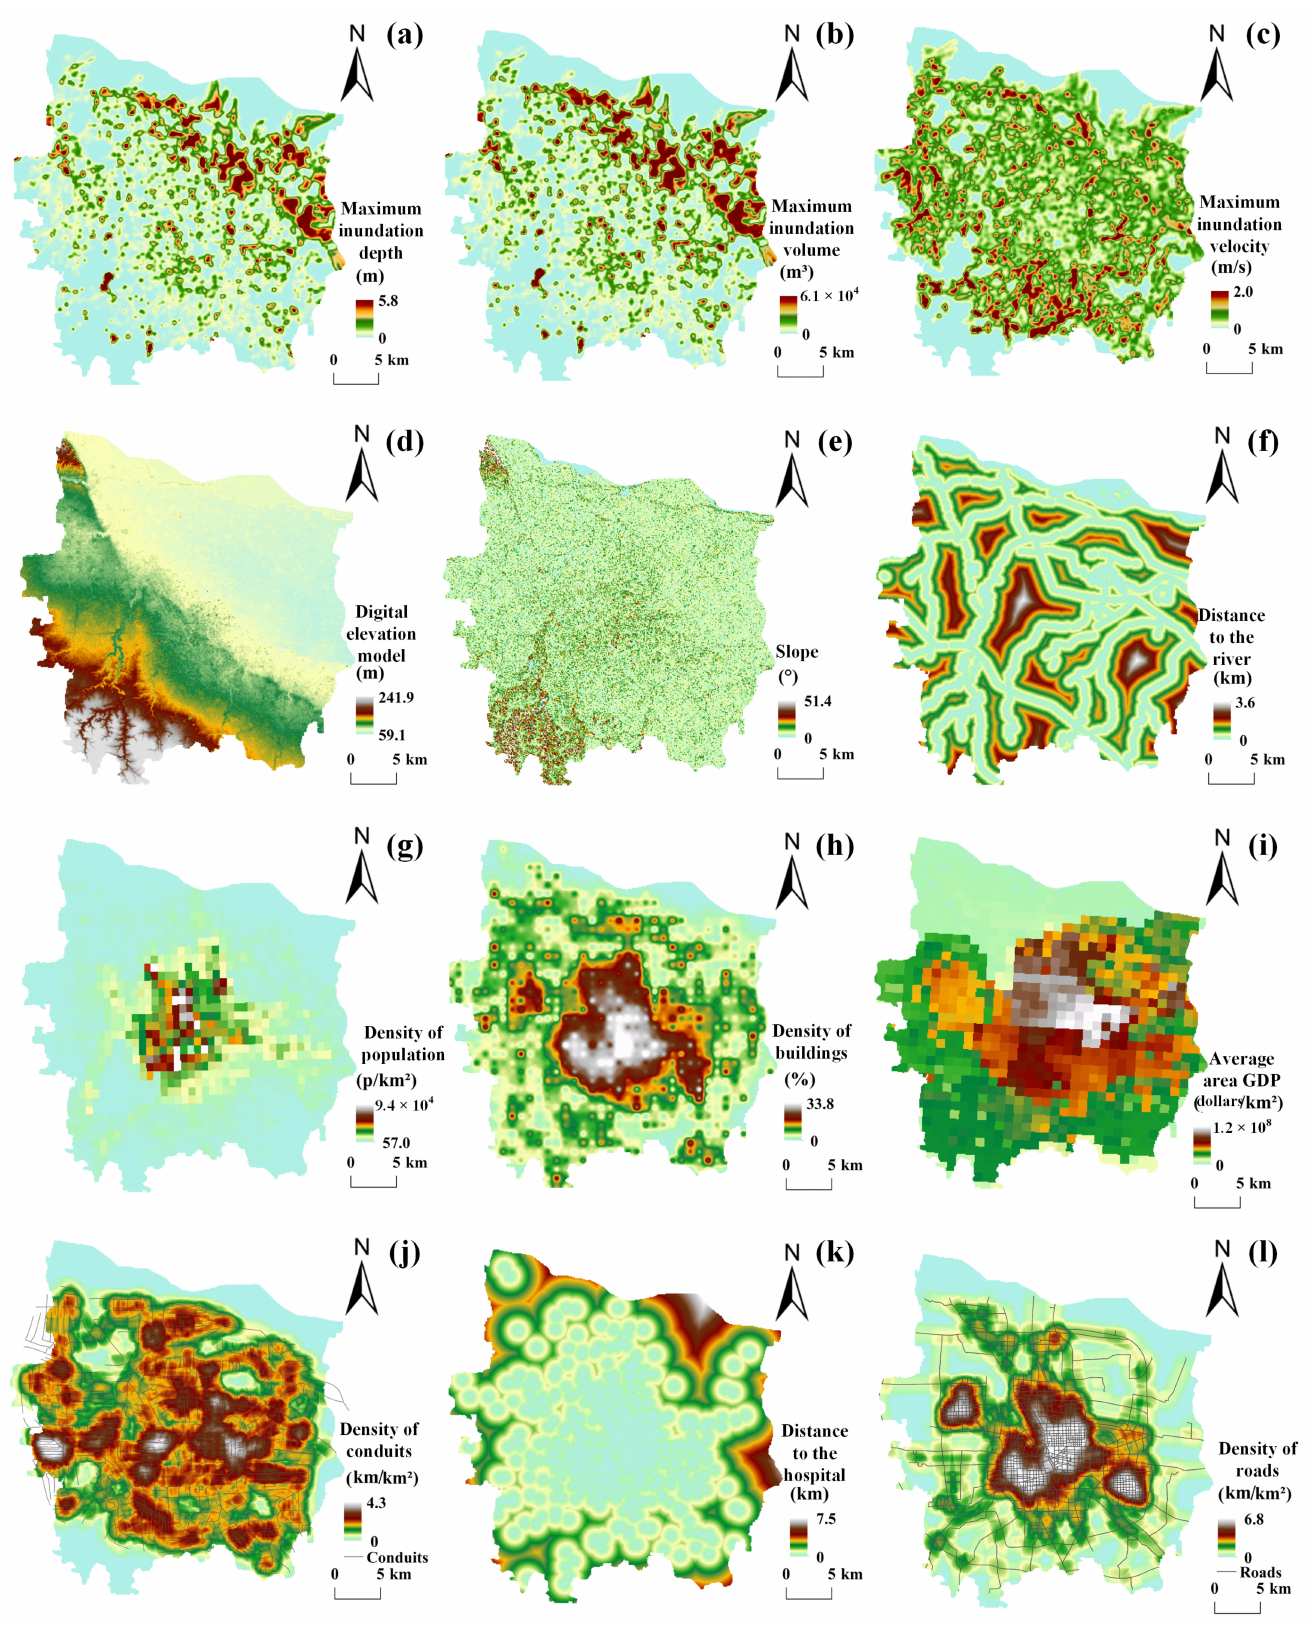
Figure 7. Spatial distribution of the evaluation indices ( a ) MD, ( b ) MVO, ( c ) MVE, ( d ) DEM, ( e )